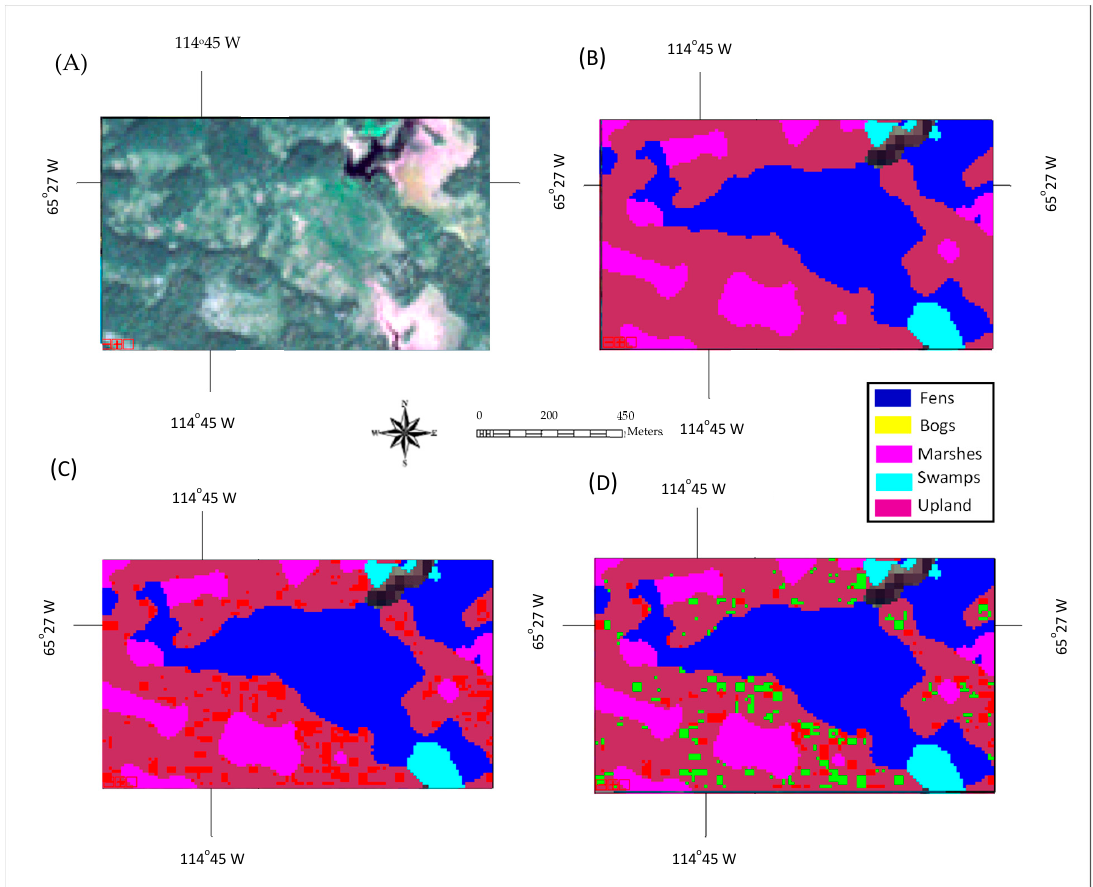
Figure 4. Classification result of a test area dominated by upland: ( A ) true-color composite of a Sentinel-2 image; ( B ) ground-truth-based classification map; ( C ) classification map using the proposed method. Misclassified pixels highlighted in red; ( D ) Classification map using Classifier #1, where the misclassified pixels, which were corrected using the proposed method, are highlighted in green.